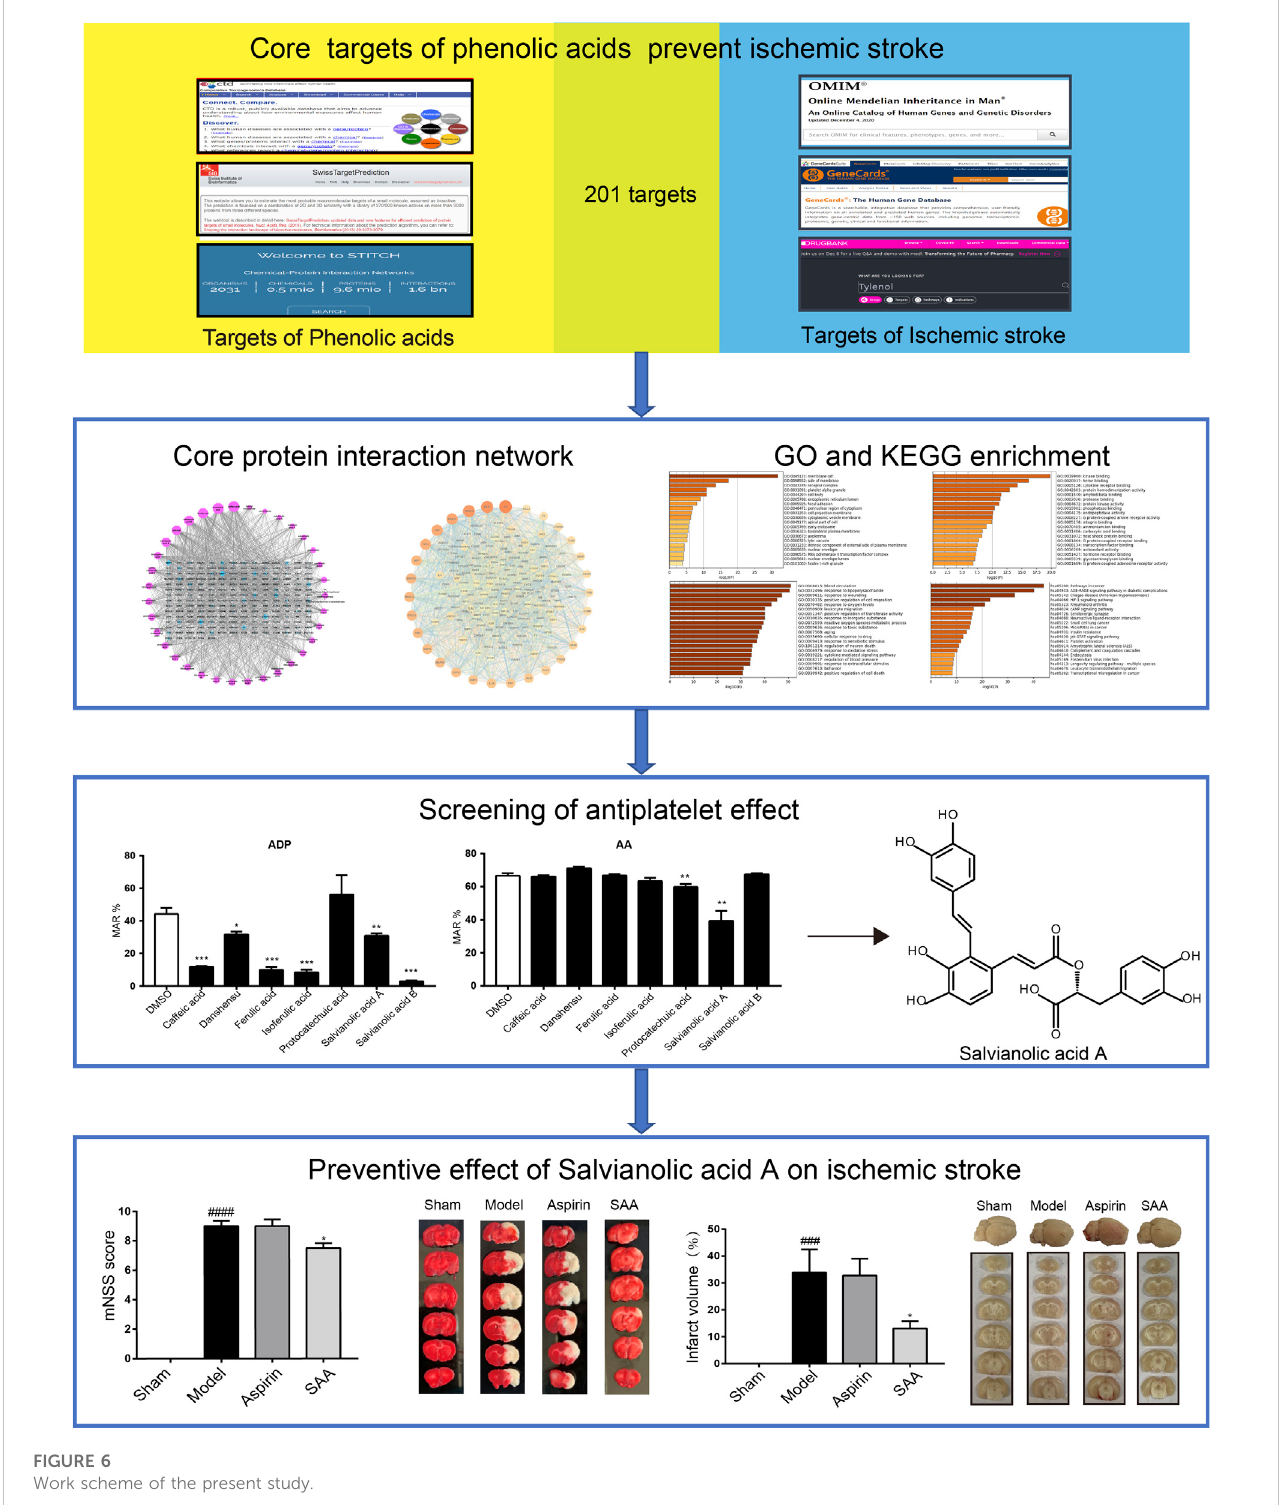
FIGURE 6 Work scheme of the present